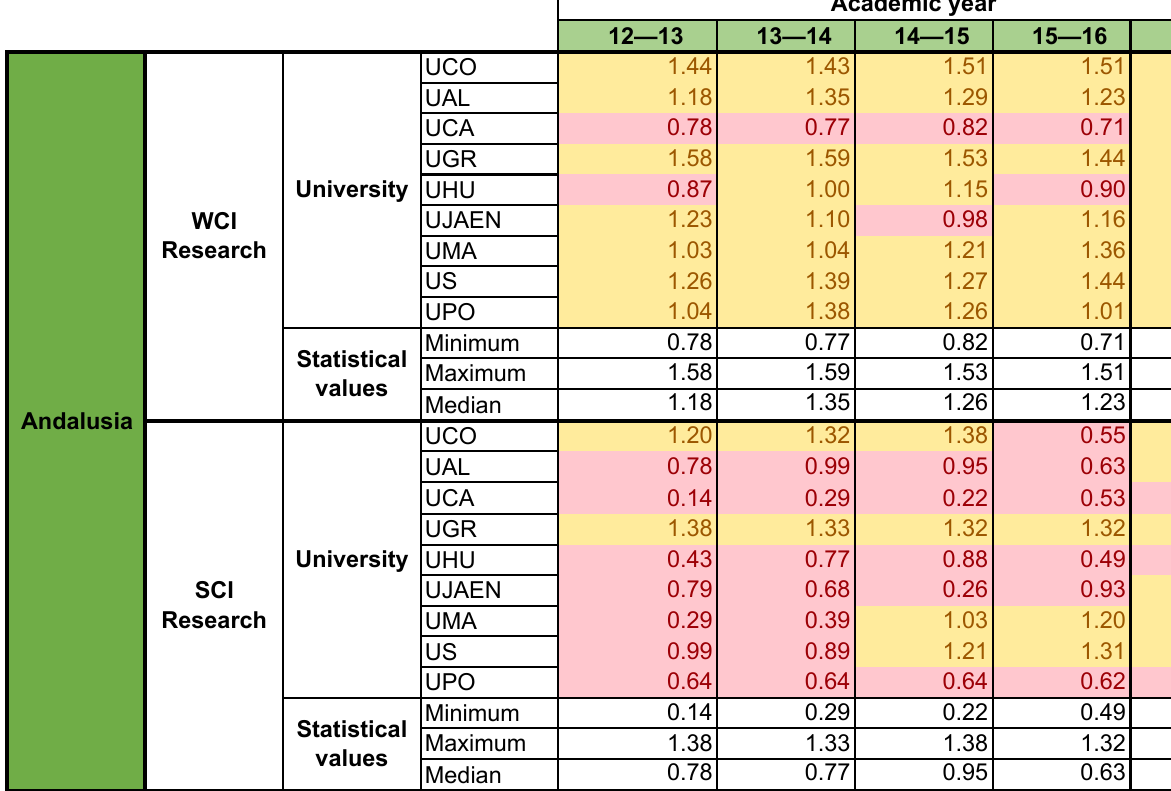
Figure A9. WCI and SCI values of the Andalusian public universities in their research